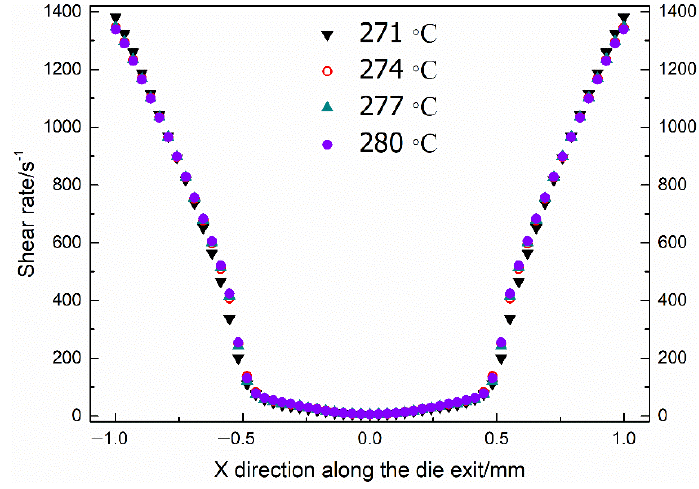
Figure 6. Distributions of the shear rate along the X direction at the die exit. Table 1. Calculation of the characteristic relaxation time and average shear viscosity for PET melt at different